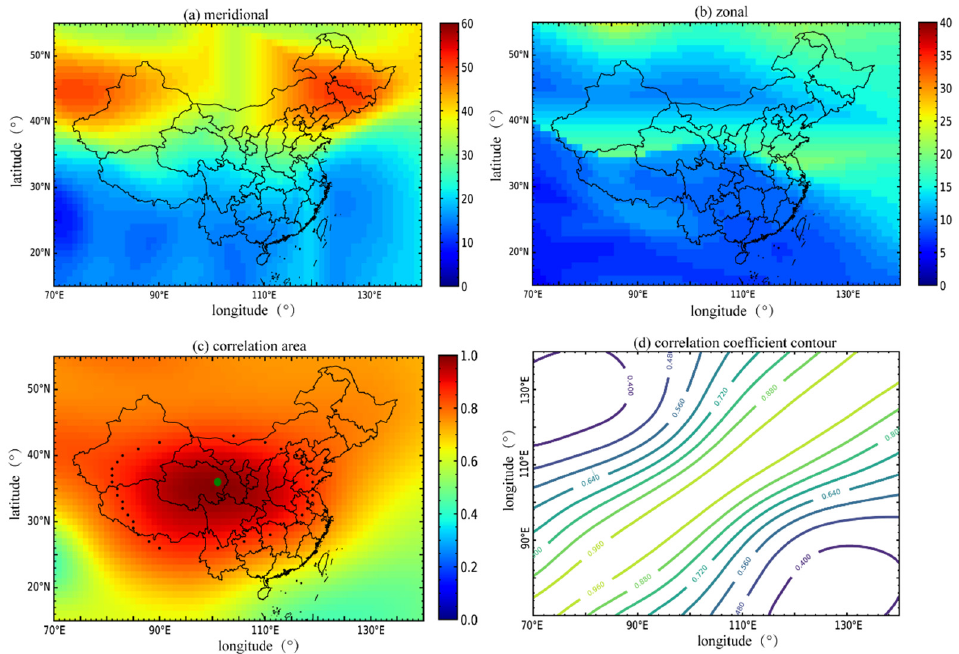
Figure 1. The distribution of the correlation coefficient and correlation length under magnetic static period (AP < 30), and middle solar activity (100 < F10.7 < 150) condition during winter (January– March) at 00:00 UT. Where ( a ) is the distribution map of meridional correlation length; ( b ) is the zonal correlation length distribution map; ( c ) is the reference points and their related regional distributions; ( d ) is the meridian contour distribution at 70 ◦ E and 15 ◦